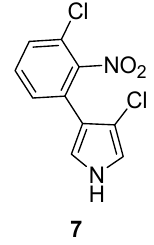
Figure 2. Chemical structure of pyrrolnitrin ( 7 ).